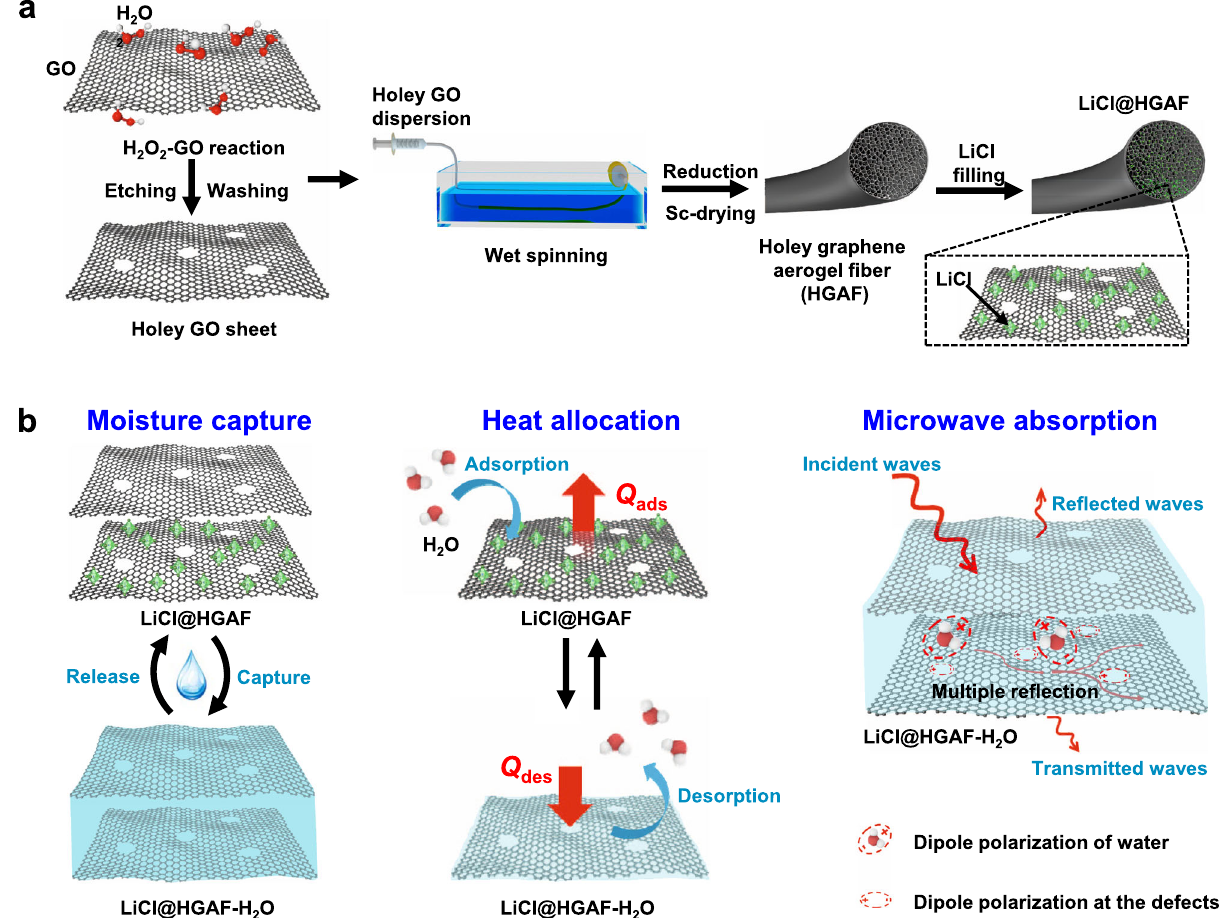
Fig. 1 Fabrication strategy and application of LiCl@HGAFs. a Schematic illustration of the fabrication of hygroscopic holey graphene aerogel fi bers (LiCl@HGAFs). HGAFs were obtained by wet spinning, HI reduction, and supercritical drying. LiCl was introduced by simple impregnation. b Schematic illustrations on moisture capture, heat allocation, and microwave absorption, respectively. LiCl in the fi ber can effectively capture moisture and liquefy it, which can be regenerated by heating and harvested water. The adsorption heat is generated in the adsorption process ( Q ads ) and the heat is absorbed in the regeneration process ( Q des ). This heat transfer property makes the LiCl@HGAFs applicable in heat storage and heat distribution allocation. In the process of moisture capture, the liquid water produced in the fi bers has a signi fi cant loss effect on microwave adsorption, which can signi fi cantly improve the microwave absorption performance of the fi